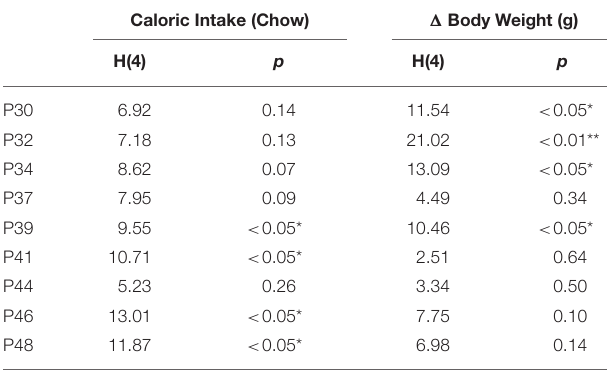
TABLE 2 | Kruskal-wallis test of significance of caloric intake and change in body weight during the chow maintenance period. Caloric Intake (Chow) 1 Body Weight (g)